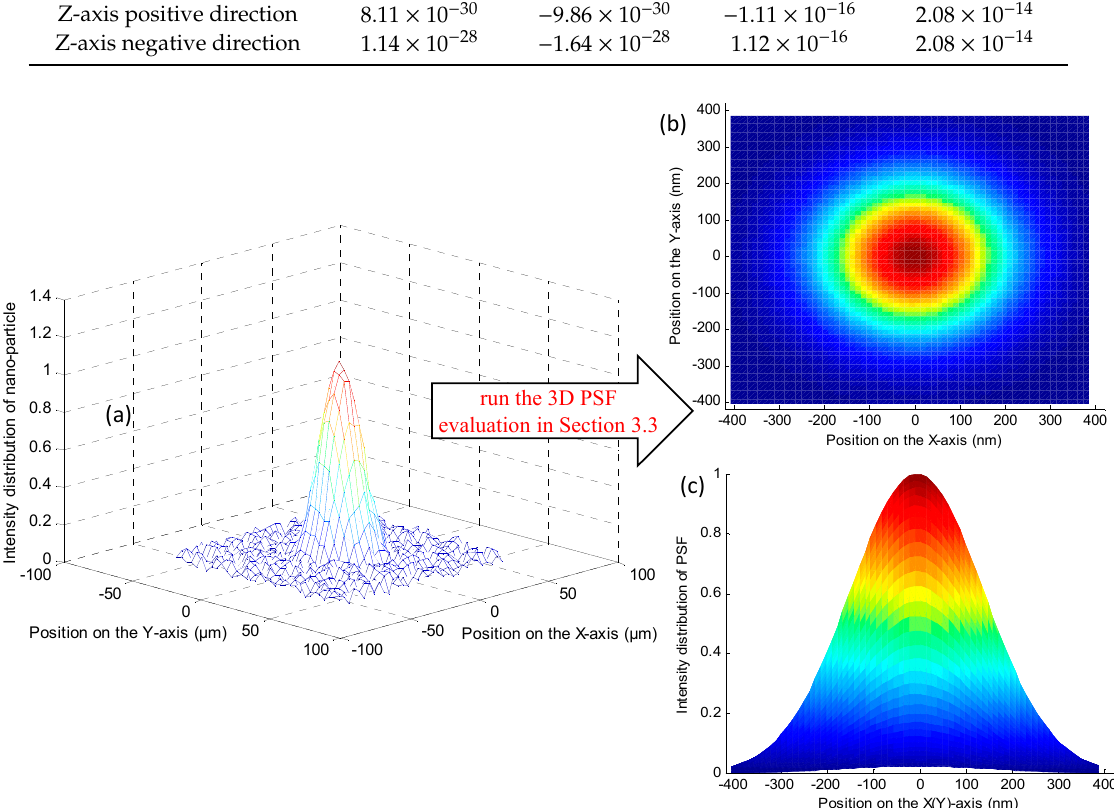
Figure 8. Intensity distribution of the nanoparticle’s image ( a ) and its PSF’s intensity distribution in the X–Y ( b ) and X–Z (or Y–Z) ( c ) planes.